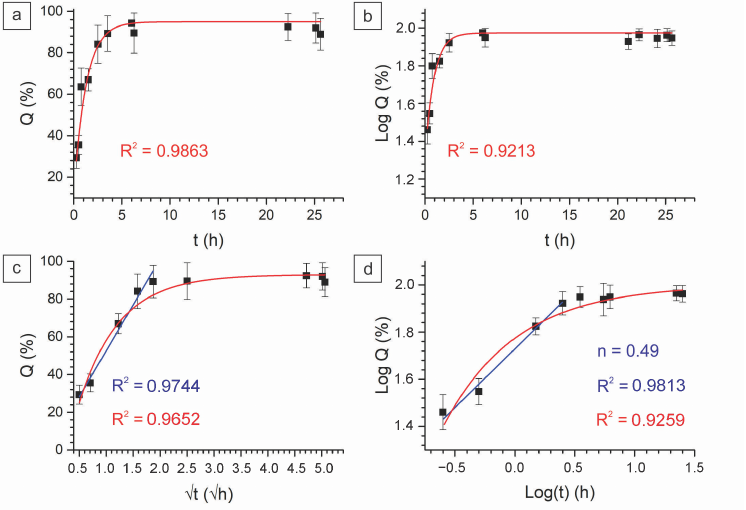
Figure 9. Release profiles of core–shell fiber PVA-PEG-SiO 2 -1x-CHX@PVA-GO fitted to the models: